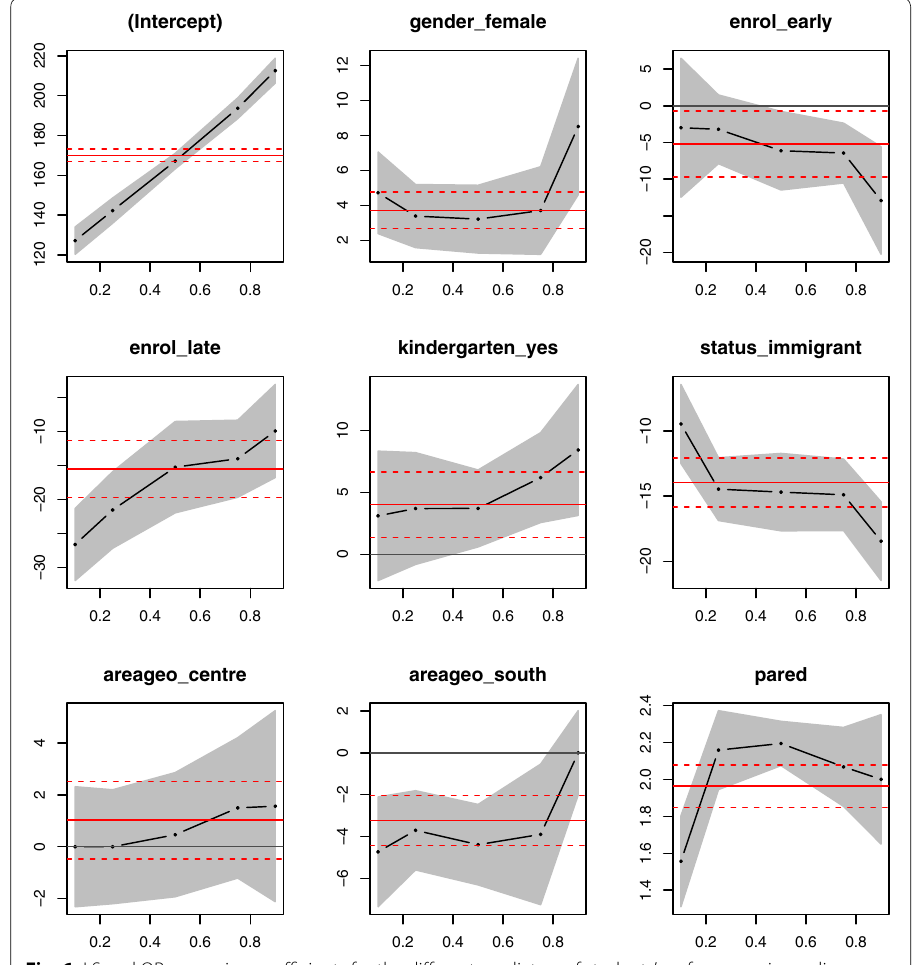
Fig. 6 LS and QR regression coefficients for the different predictors of students’ performance in reading: second-graders